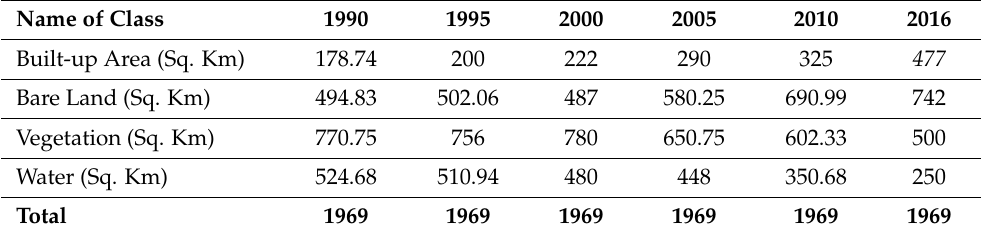
Table 3. Urban sprawl/built-up area growth with other Fields